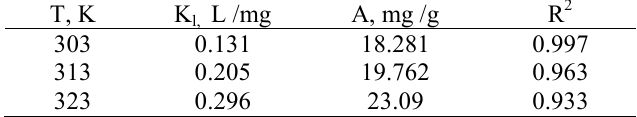
Table 4 . Parameters of Langmuir equation for the U(VI) adsorption. T, K